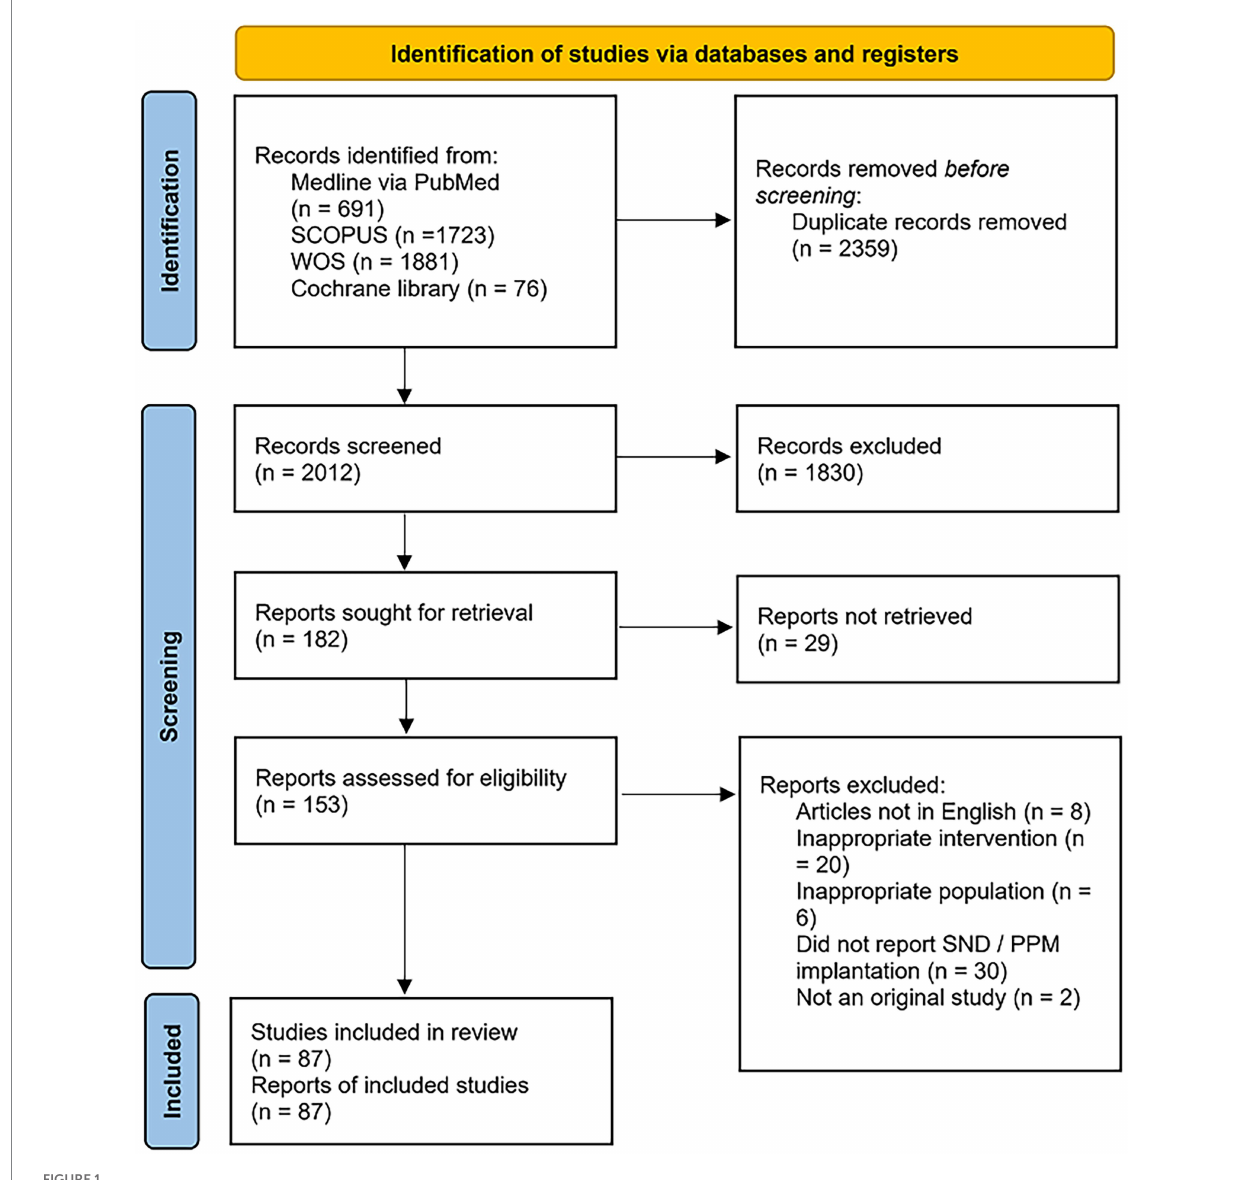
FIGURE 1 PRISMA flow diagram for the selection of included